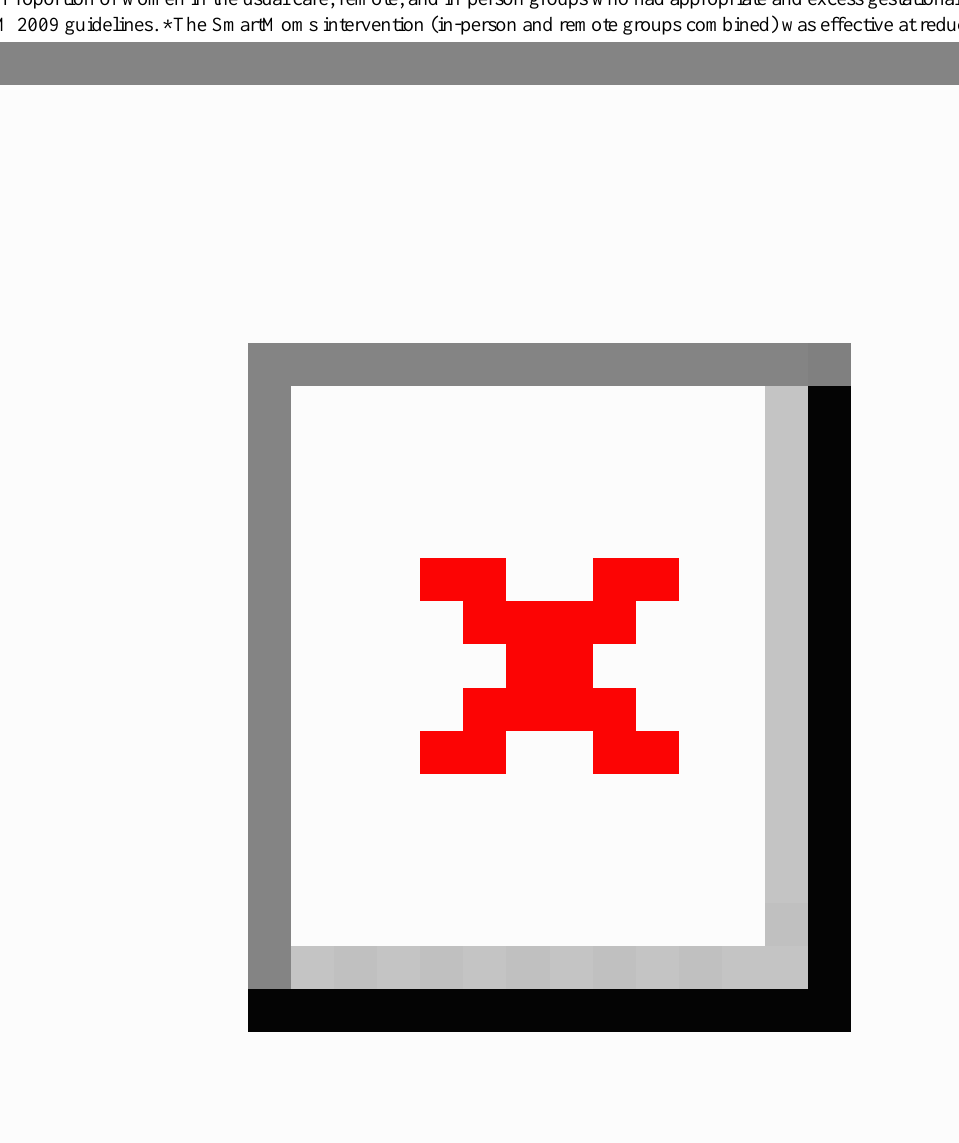
Figure 2. Proportion of women in the usual care, remote, and in-person groups who had appropriate and excess gestational weight gain (GWG)